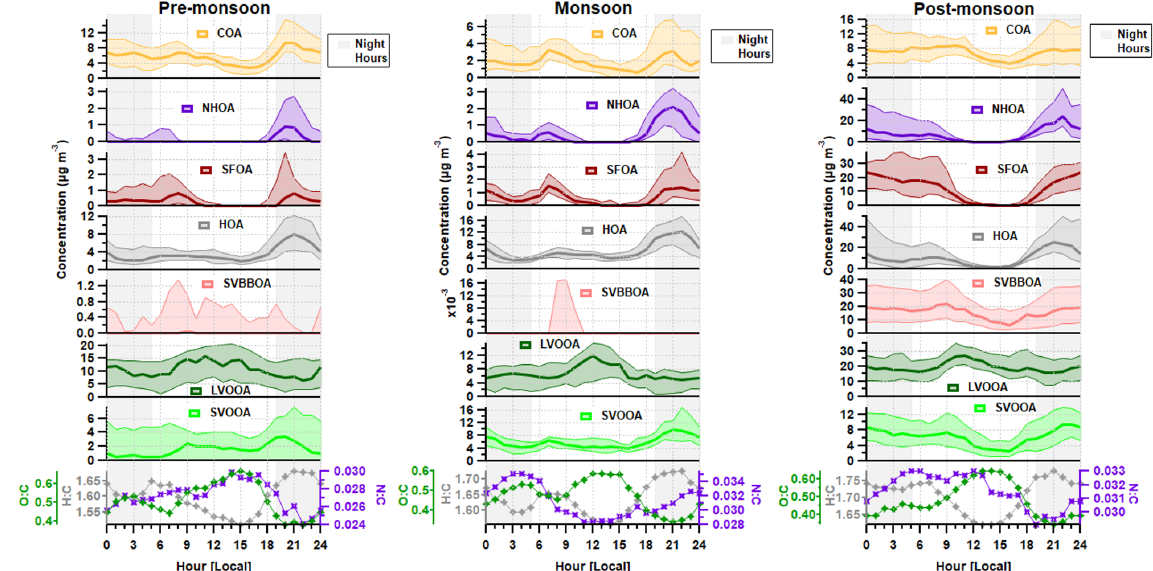
Figure 8. Median diurnal cycles of the factor solutions for the three measurement periods (interquartile range indicated by the shading) along with the elemental ratios. Regions shaded in grey are night hours.